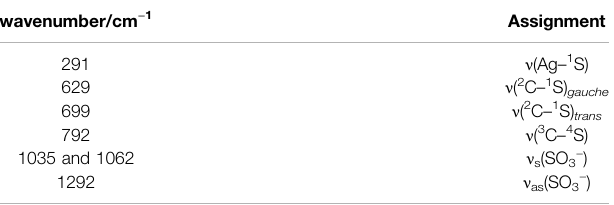
TABLE 3 | Vibrational assignment of the most intense SERS bands of MES on Fe 3 O 4 /Ag